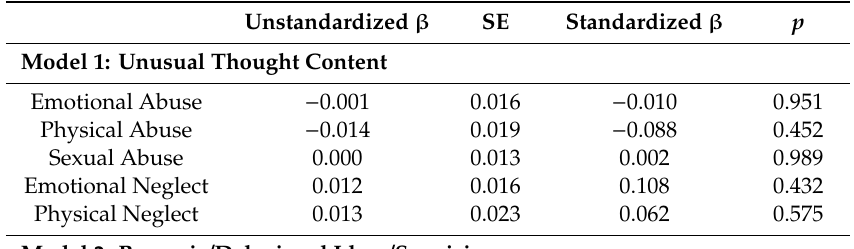
Table 4. Regressions for attenuated positive symptoms and all trauma types without individuals at CHR ( n = 116). Bonferroni corrected significant p -value =